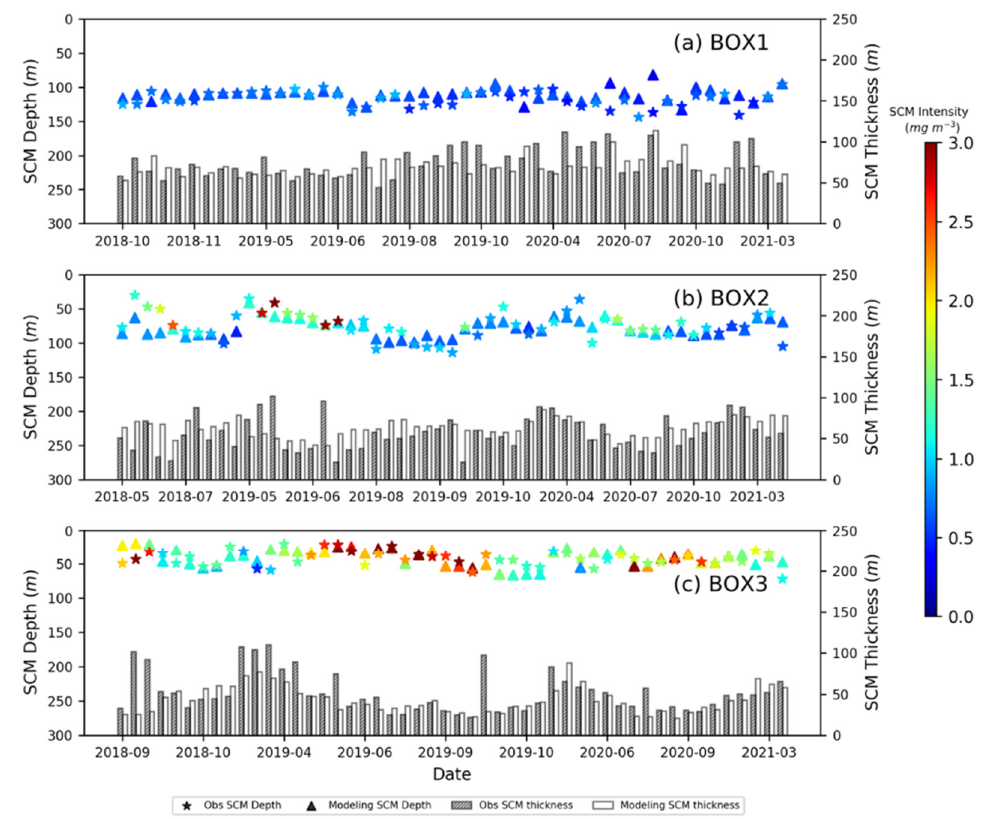
Figure 6. Comparison of SCM characteristics (depth, intensity, and thickness) obtained from the IDNN results in the test set and observation profiles along trajectories of three BGC-Argo (No. 2902756 ( a ), No. 2902748 ( b ), and No. 2902755 ( c ) in BOX1 – BOX3, respectively).